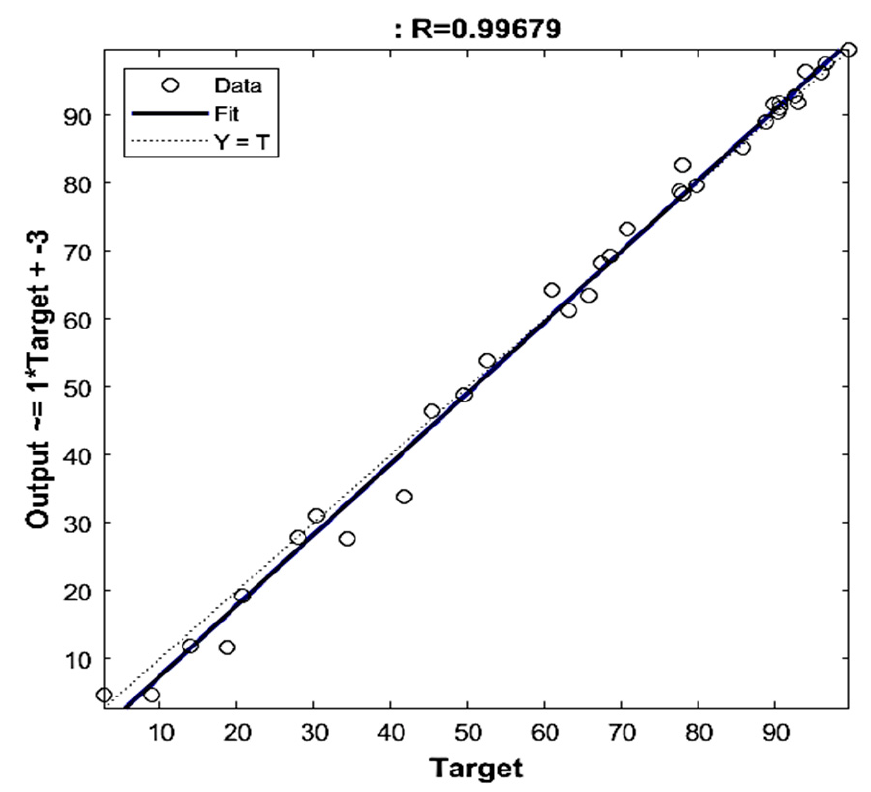
Figure 5. Regression of the simulated datasets for the (5-15-10-1) ANN model. Table 7. Statistical parameters of the (5-15-10-1) model for the simulated data.